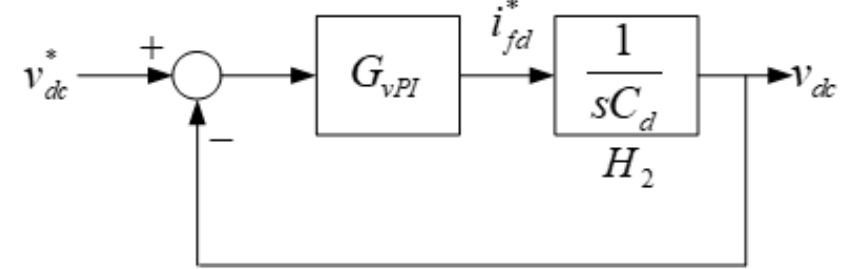
Figure 7. Schematic architecture of the complete LVRTC controller ( 𝜔 (cid:3032) denotes the angular fre- quency of the system). As shown in Figures 2 and 7, when the grid voltage falls below 90% of the nominal value, the reactive current control command will be switched to LVRT mode, and perform reactive power command tracking control. In this study case, the system specifications of the inverter are as follows: system rating: 2kVA; grid voltage V L-L : 220 V/60 Hz; DC voltage V dc : 400 V; filter inductance L f : 3 mH; filter inductor resistance r l : 3.5 Ω ; DC link regulator capacitance C d : 560 μ F; and switching frequency f SW : 18 kHz. According to these specifica- tions, the plant transfer functions of the DC voltage loop and current loop are as follows: